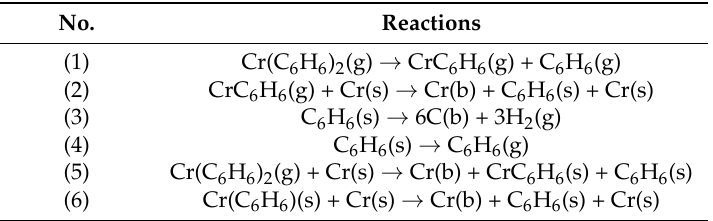
Table 1. Reaction pathways. Cr(s) is a chromium site, Cr(b) and C(b) are bulk chromium and carbon respectively, and C 6 H 6 (s) is adsorbed